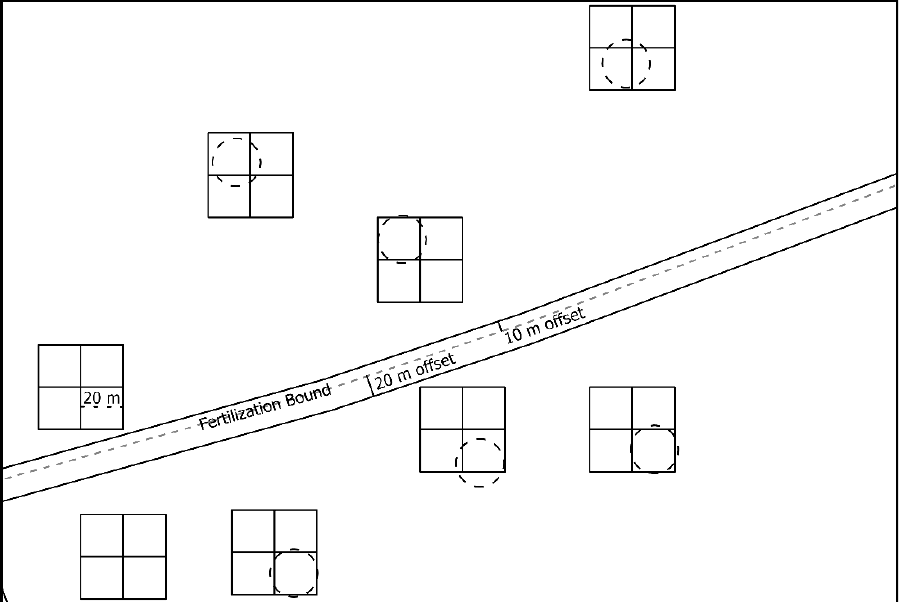
Table 1. Composition and number of final selected LiDAR-block pairs for each analysis unit.